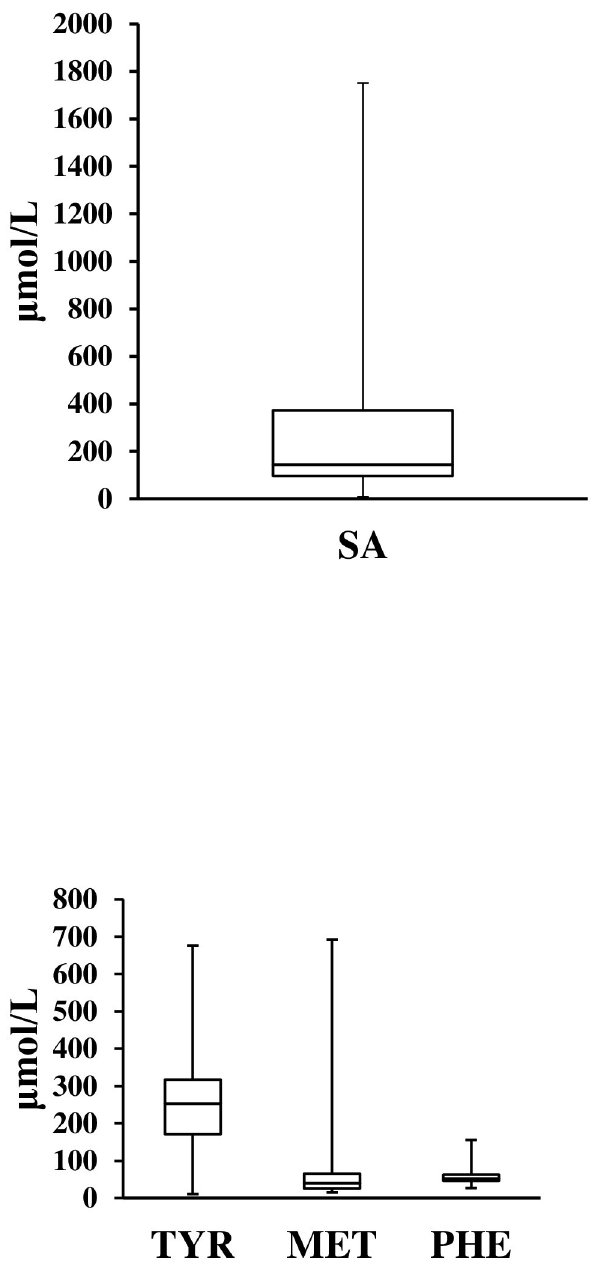
Fig 2. The median levels of succinylacetone, tyrosine, methionine and phenylalanine (in μ mol/L) in patients with hepatorenal tyrosinemia. METH = methionine; PHEN, phenylalanine; SA = succinylacetone; TYR = tyrosine.